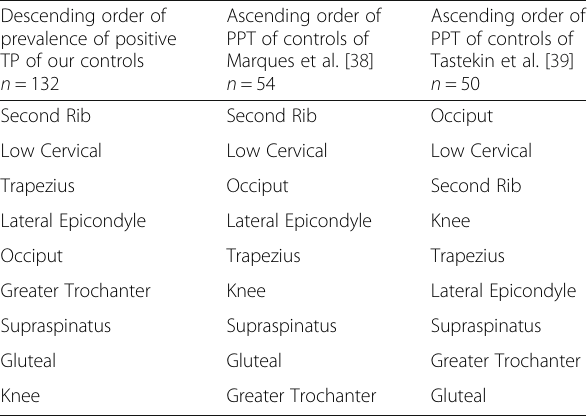
Table 5 Comparison between sites sorted in descending order of prevalence of positive TP of our controls and sites arranged in ascending order of PPT of controls in previous studies Descending order of prevalence of positive